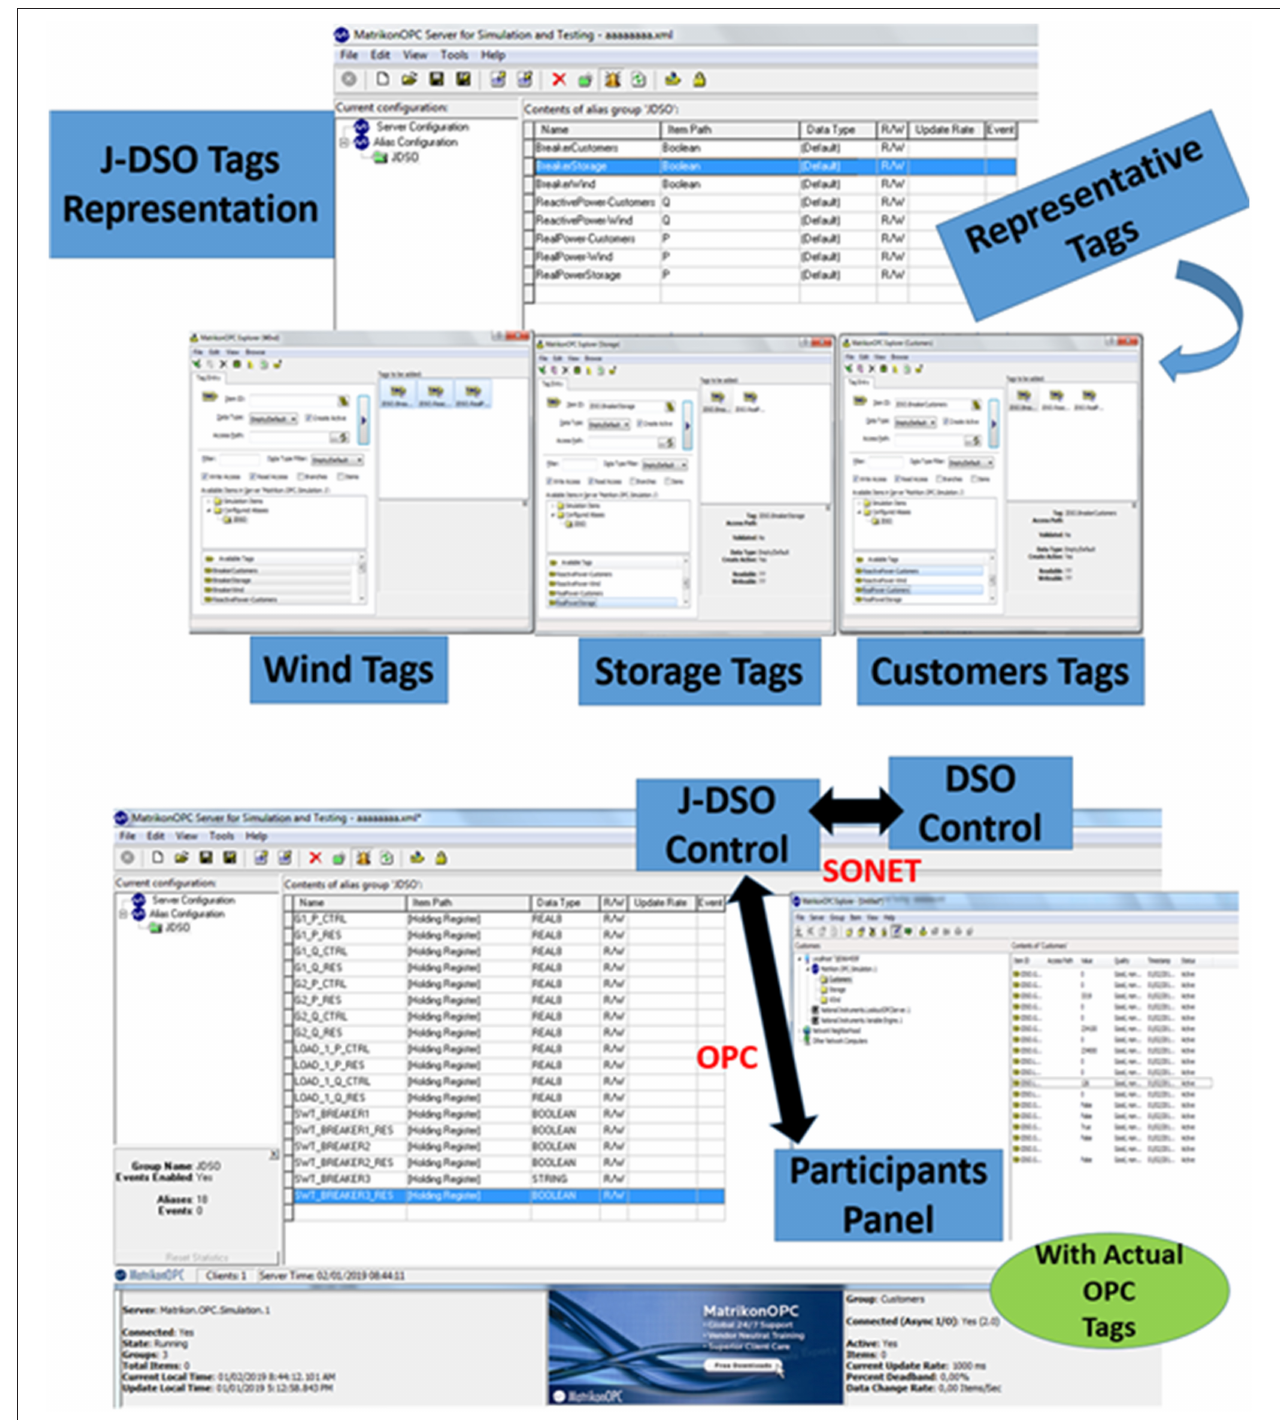
FIGURE 6 | OPC server-clients-explorer